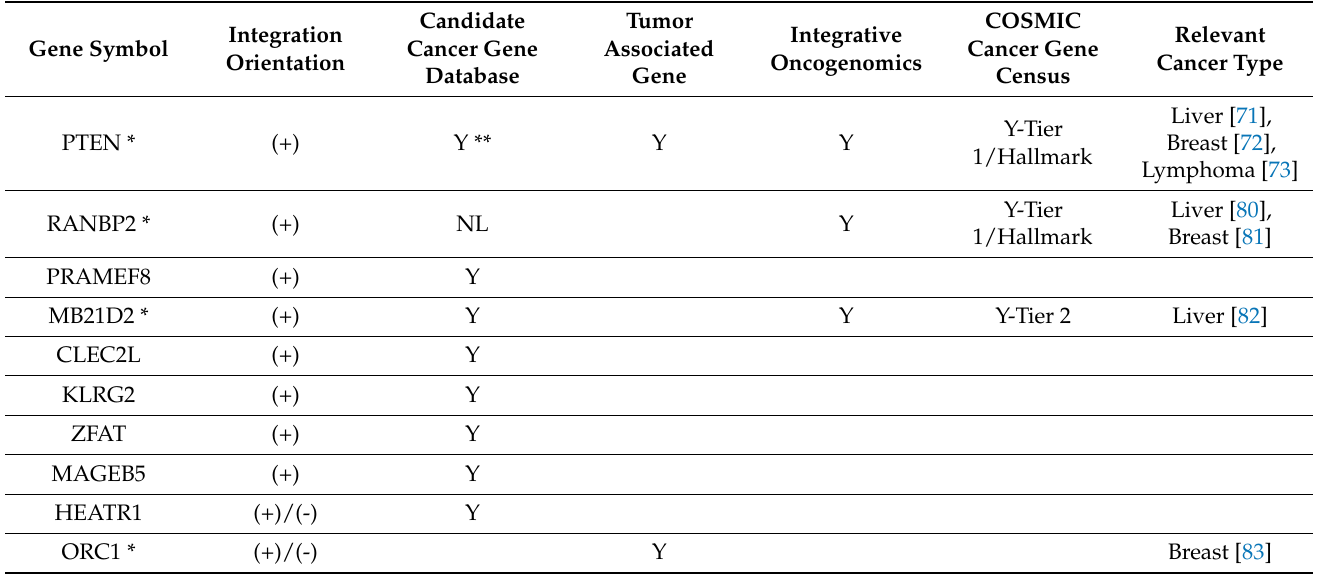
Table 1. HBRV integration sites: common insertion site (CIS) genes associated with human